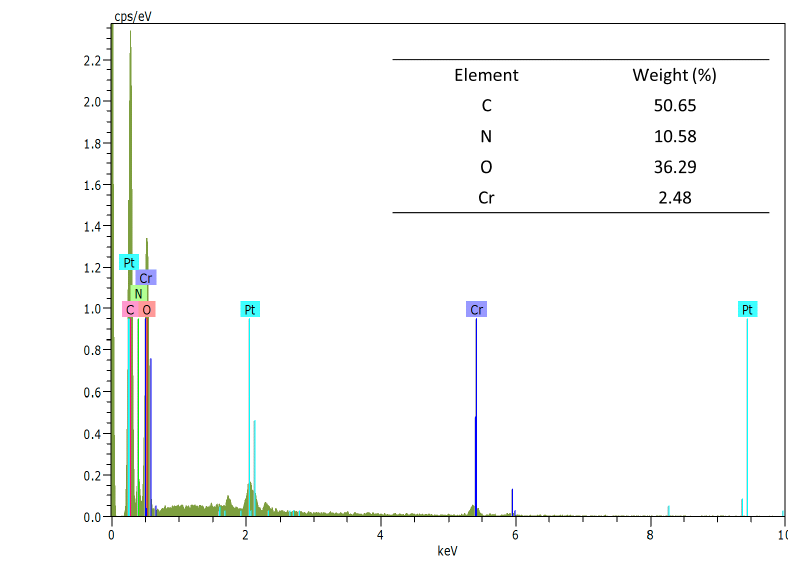
Figure 5. Energy-dispersive X-ray spectroscopy (EDS) spectra and elemental compositions of SS/KL blend beads before Cr(VI) adsorption ( a ) and after Cr(VI) adsorption ( b ).